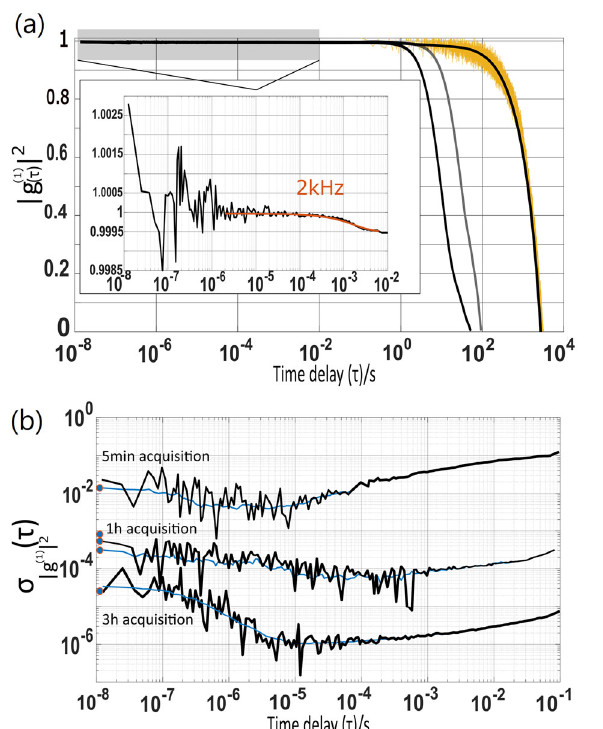
Fig. 2 Properties of the speckle intensity autocorrelation in the unperturbed quartz cavity. The laser input power is 300 mW if not stated otherwise and the light is collected with a monomode fi ber. a Normalized intensity auto-correlation ½ g ð 2 Þ ð τ Þ (cid:2) 1 (cid:4) = β as a function of the time delay τ . From left to right, acquisition times T acq in seconds are 2.5 × 10 3 , 3.6 × 10 3 , and 6.5 × 10 3 . Each dark curve is the average of three repetitions and smoothed by a moving average window along the logarithmic time, with a width corresponding to a factor 2. The yellow curve represents one of those repetitions. The insert magni fi es the initial decorrelation for T acq = 3.6 × 10 3 s fi tted by an exponential decay at 2 kHz (red line). b Noise (standard deviation) of the intensity autocorrelation function (black lines) measured for different acquisition times. The blue lines are moving averages of the raw data and the blue dots are additional data points showing the value of the noise standard deviation at the shortest measurable time delay (12.5 ns) for acquisition times T acq of 5, 30, 60, 120, and 180 min from top to